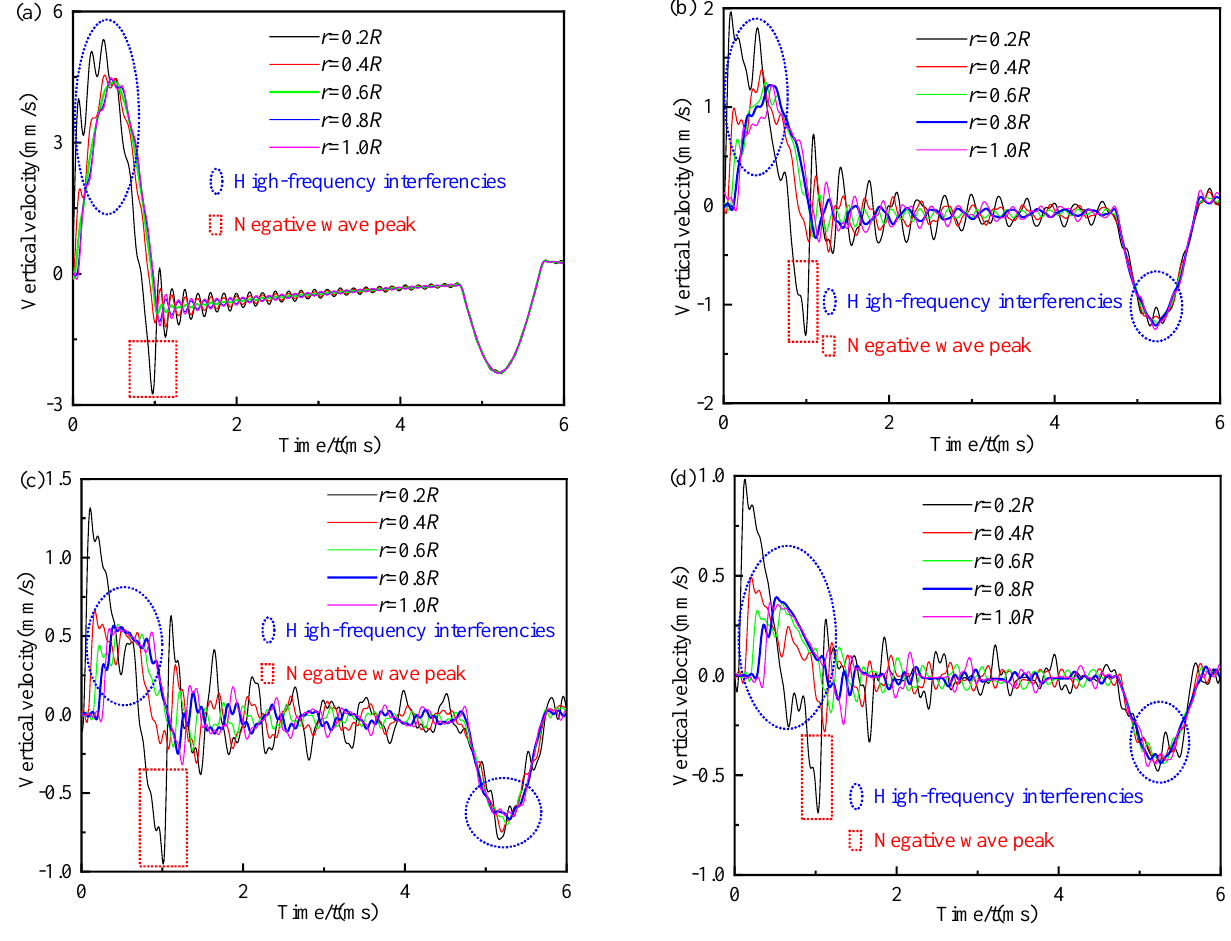
Figure 10. Vertical velocity time histories of the different test points at pile top along the radial direction outside the excitation region: ( a ) R = 0.25 m; ( b ) R = 0.5 m; ( c ) R = 0.75 m; ( d ) R = 1.0 m.